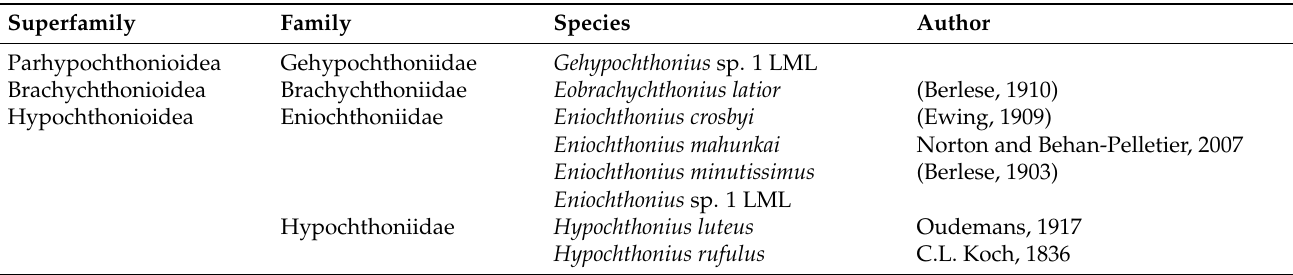
Table A1. Summary of oribatid mite species detected in the oil sands region of Alberta,